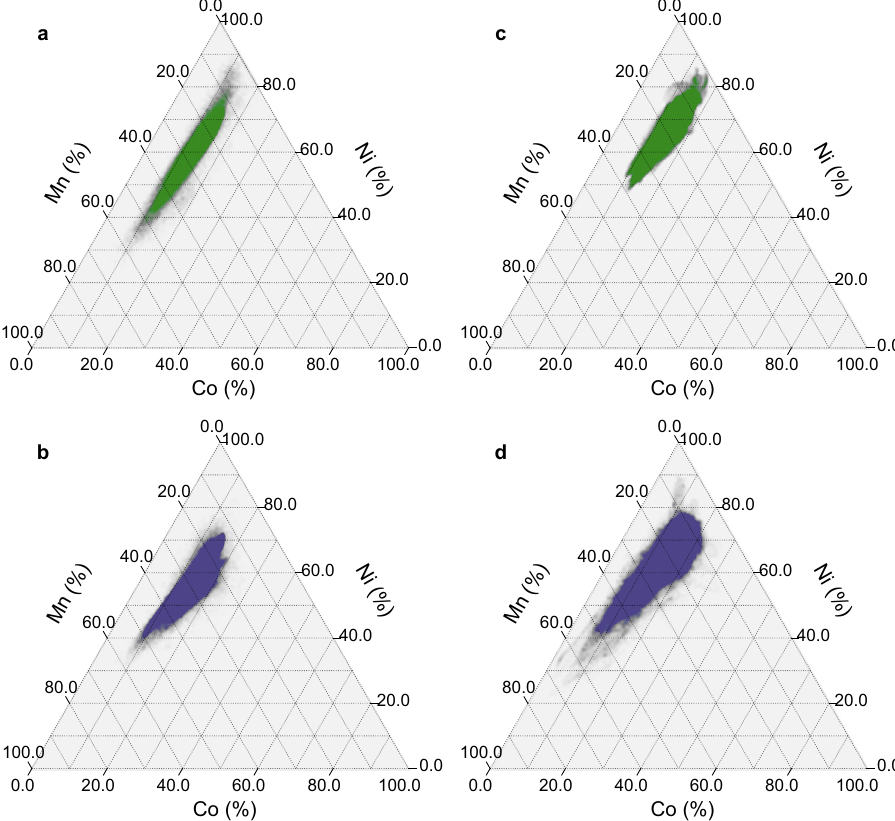
Fig. 5 Three main elemental concentrations of the NMC particles before and after the XRF image enhancement process. The main elemental concentration distributions of the NMC particles from directly obtained XRF images measured with the ( a ) FZP and ( b ) MLLs, respectively. c , d Corresponding main elemental concentration distribution of the NMC particles for the resolution-enhanced XRF images using the FZP and MLLs,